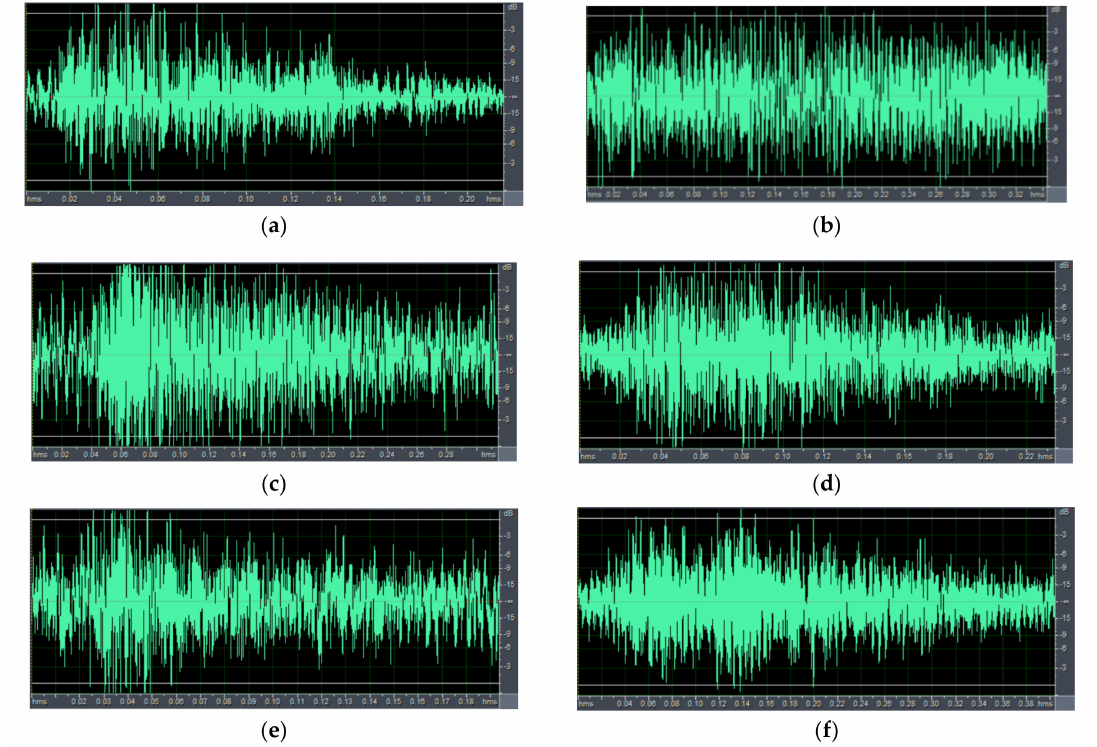
Figure 5. Examples of pig sound signals: ( a ) Normal (healthy cough); ( b ) Normal (grunt); ( c ) mycoplasma hyopneumoniae (MH); ( d ) postweaning multisystemic wasting syndrome (PMWS); ( e ) porcine reproductive and respiratory syndrome (PRRS); and ( f ) Scream. The horizontal axis denotes the time in seconds and the vertical axis denotes the sound signal in